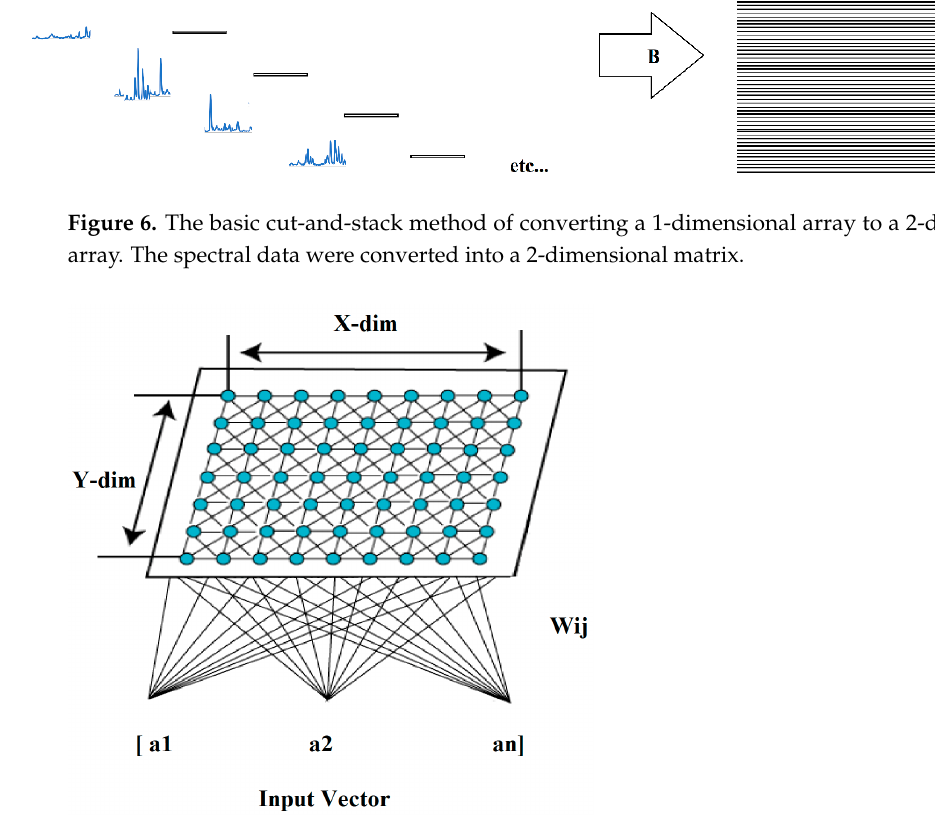
Figure 7. Using the SOM unsupervised deep-learning model to generate a 2-dimensional array from the spectral data. The 1-dimensional spectral data array was fed to SOM model and projected onto a 2-dimensional feature map.